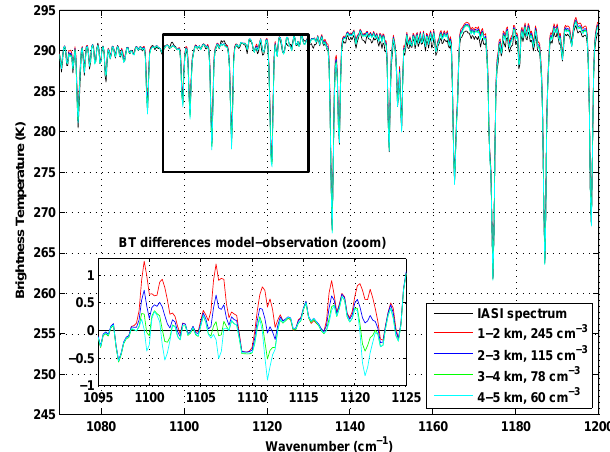
Fig. 4. Modelled brightness temperature (BT) spectra with the dust aerosol layer placed at different altitudes (aerosol concentration such that the general baseline of the spectrum is reproduced in the selected spectral window, right part of the V-shape), and a measured IASI spectrum (17.57 ◦ N, 25.82 ◦ W; 22 June 2009 11:47 UTC). The insert shows the BT difference between the modelled spectra and the IASI spectrum, for a small wavenumbers window, emphasizing the impact on water vapour absorption